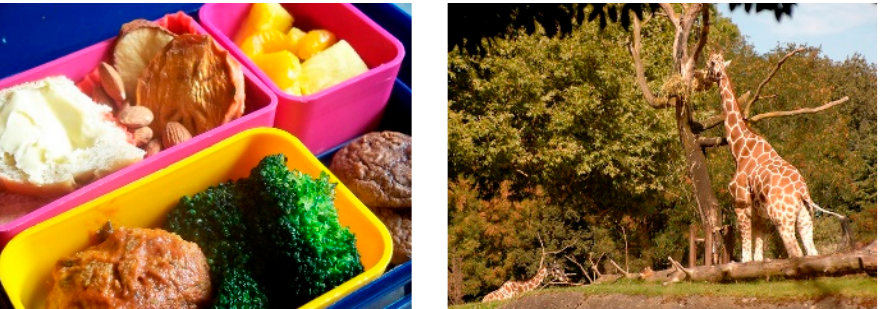
Figure 9. Schematic diagram of COCO [41] dataset model. Reprinted with permission from Ref.